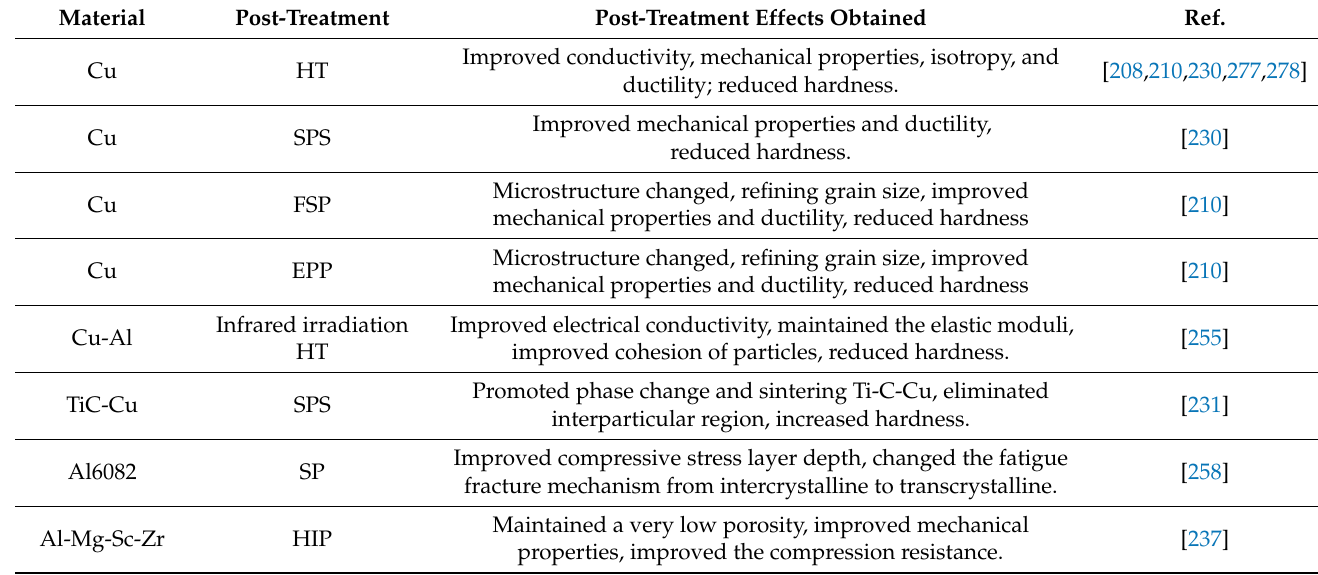
Table 3. Post-treatments applied for